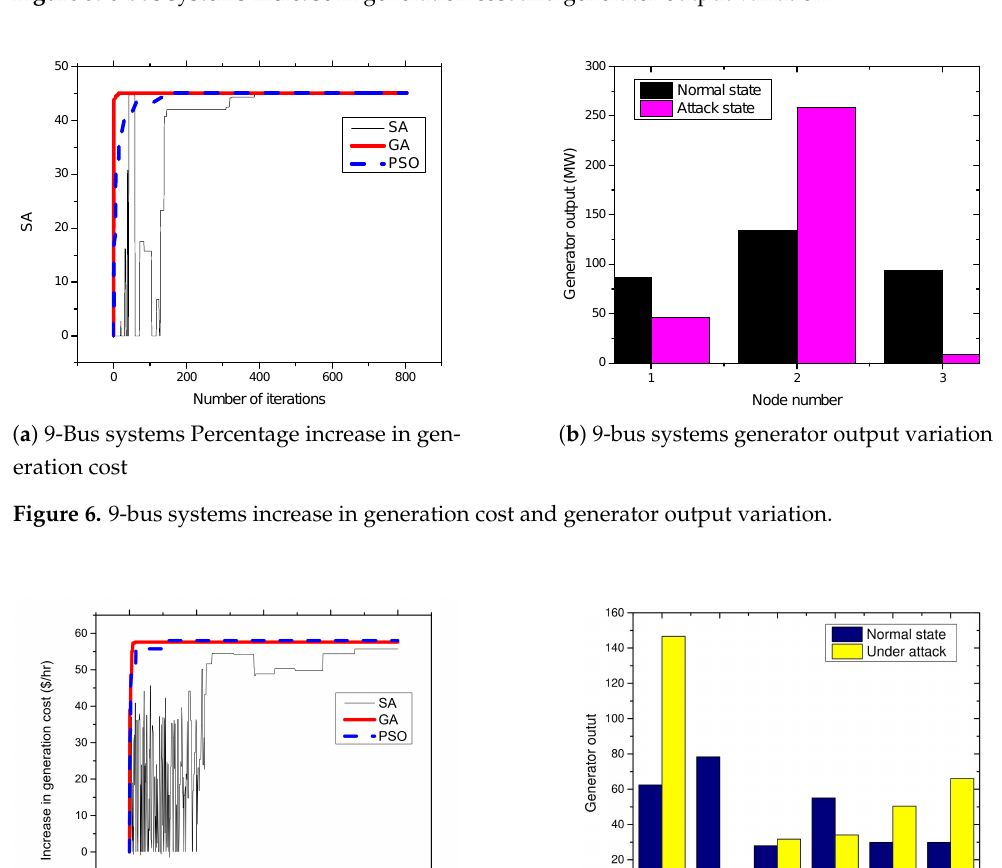
Figure 5. 6-bus systems increase in generation cost and generator output variation.